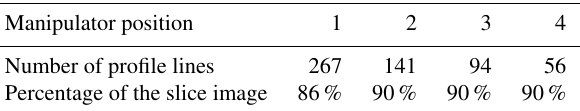
Table 3. Number of evaluated profile lines within the reconstructed component volume depending on the voxel